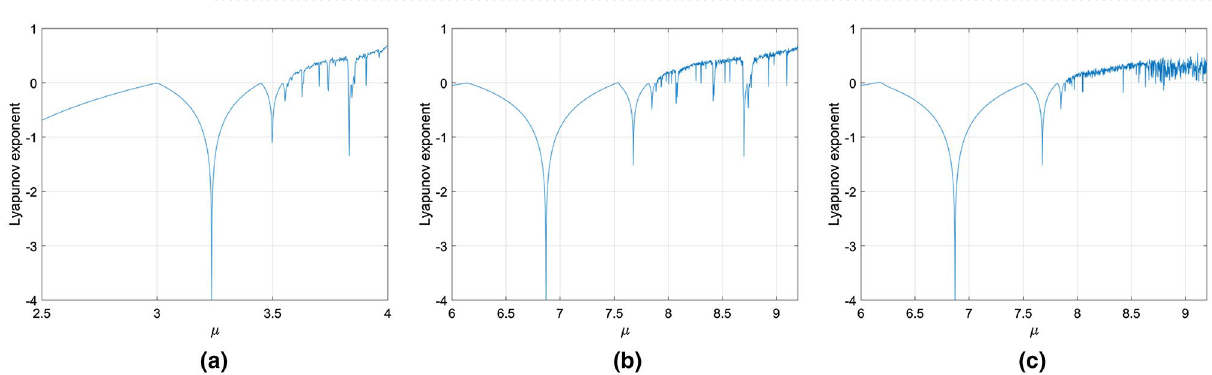
Figure 5. Lyapunov exponent curves. ( a ) The traditional logistic chaotic system 52 , ( b ) the fractional-order chaotic logistic system with α = 0.85, r = 0.25 52 , ( c ) the 2DCML fractional-order chaotic system with α = 0.85, r = 0.25, ε = 0.39